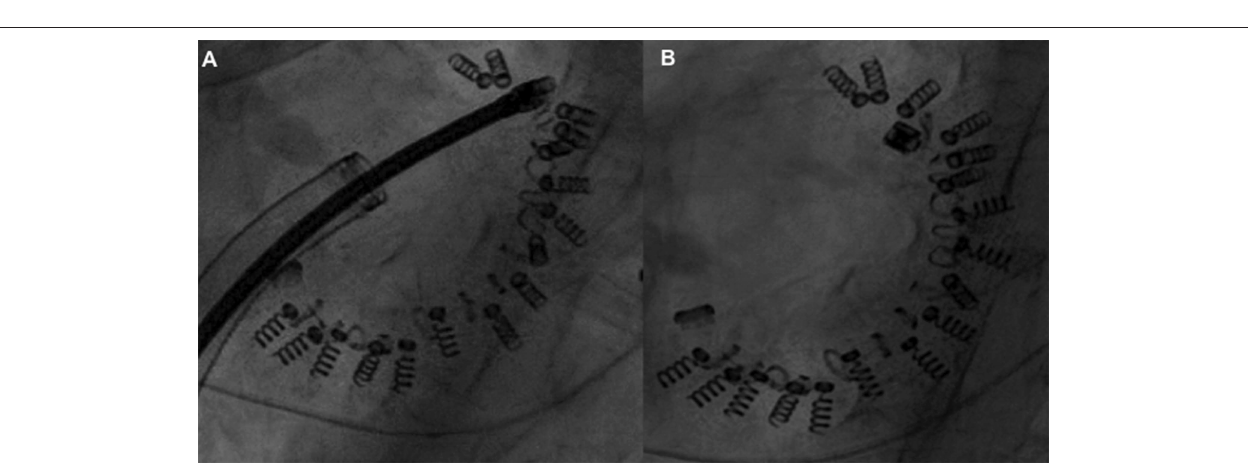
FIGURE 6 | Flow reduction on distal left circumflex (A) after the third anchor placement managed by balloon inflation (B) which caused anchor detachment with residual coronary-left atrial fistula ( C , arrow) managed conservatively (covered stent did not advance through the left main toward the left circumflex) with the resolution at 1 month.